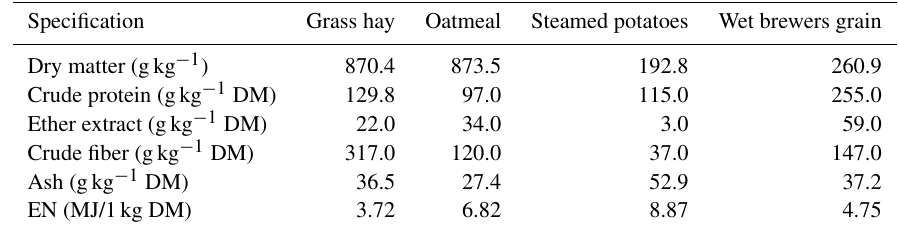
Table 1. The chemical composition and nutritional value of feeds used in lambs fattening.